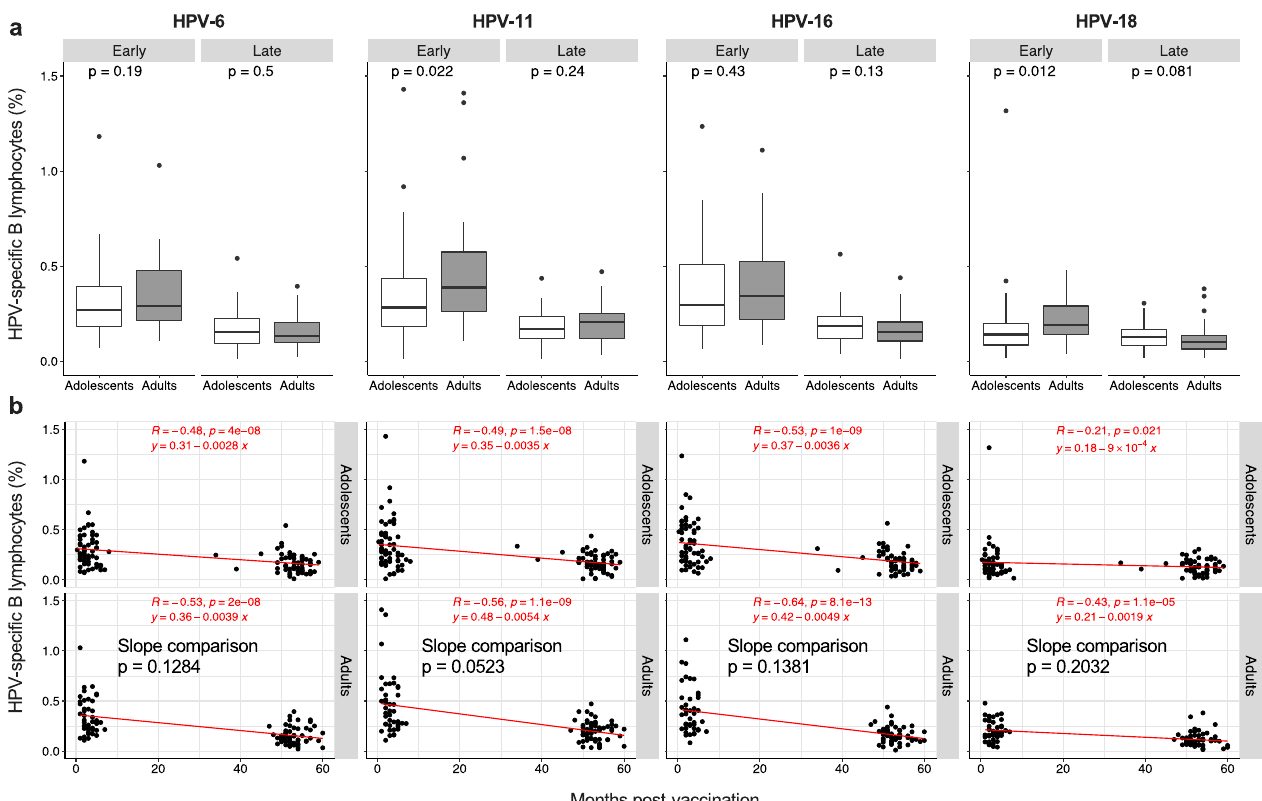
Fig. 4 Induction and maintenance of HPV-speci fi c memory B lymphocytes. a , b HPV-6, HPV-11, HPV-16, and HPV-18-speci fi c memory B lymphocytes measured by B cell Elispot assay are shown as box and whisker plots ( a ) and correlated with the months post-vaccination ( b ); n = 58 and n = 59 for adolescents of the “ Early cohort ” and the “ Late cohort ” , respectively; n = 44 and n = 56 for adults of the “ Early cohort ” and the “ Late cohort ” , respectively. Box and whisker plots are as in Fig. 1. Statistical signi fi cance was determined by the Mann-Whitney ( a ) and Spearman ’ s rank correlation ( b ) and all p -values are shown. The comparison between slopes (adolescents vs adults) was calculated by ANCOVA ( b ). “ Early cohort ” , Early; “ Late cohort ” ,